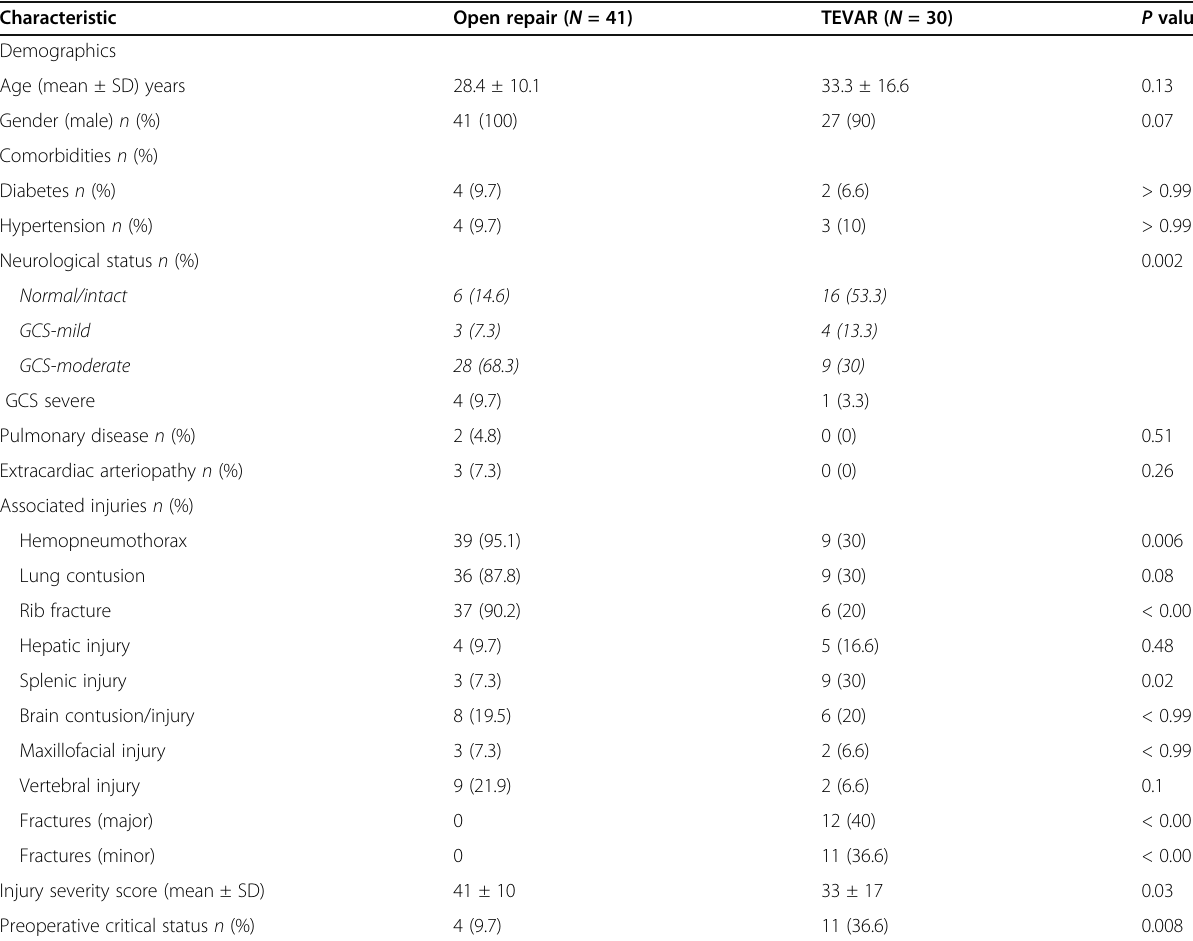
Table 1 Preoperative